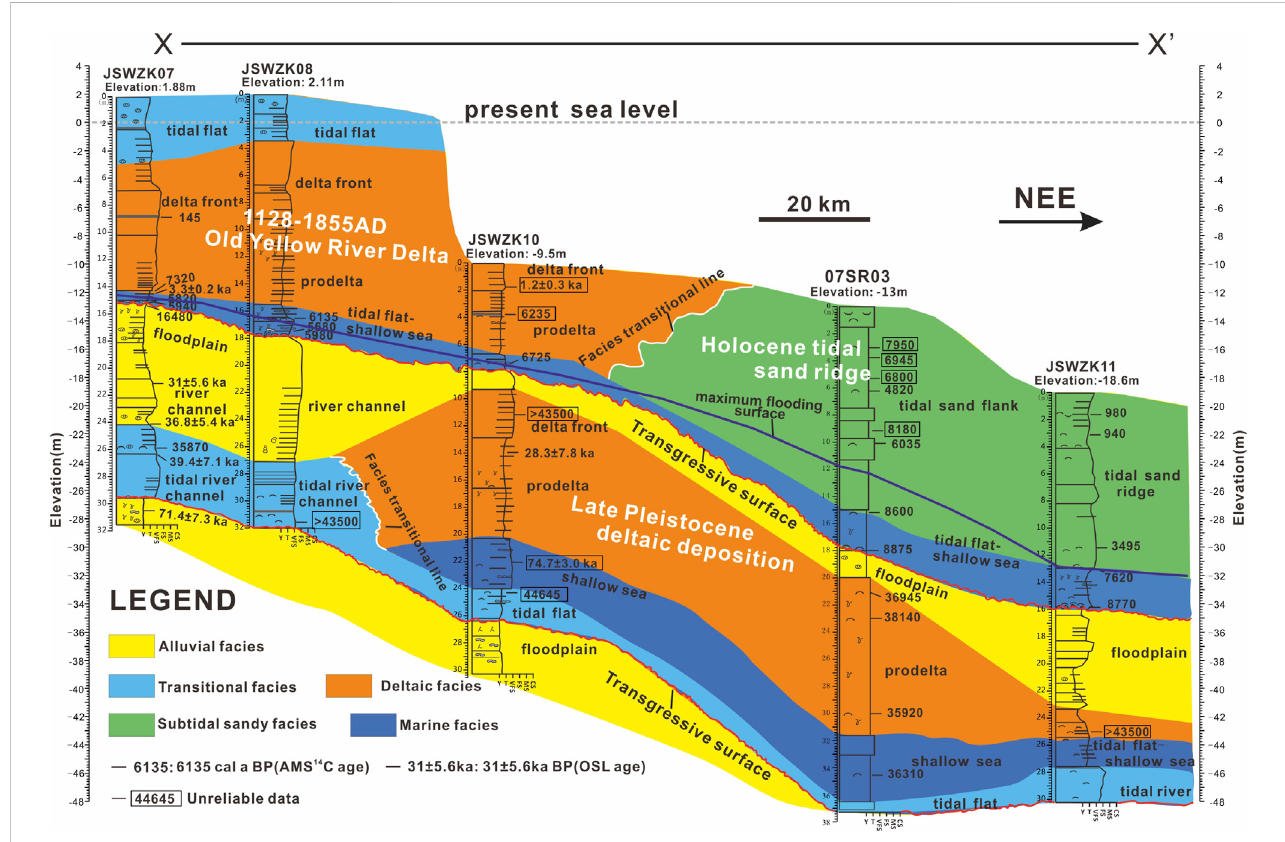
FIGURE 8 Facies architecture along coastal transect X-X ′ . The core 07SR03 is modi fi ed from Zhang et al.